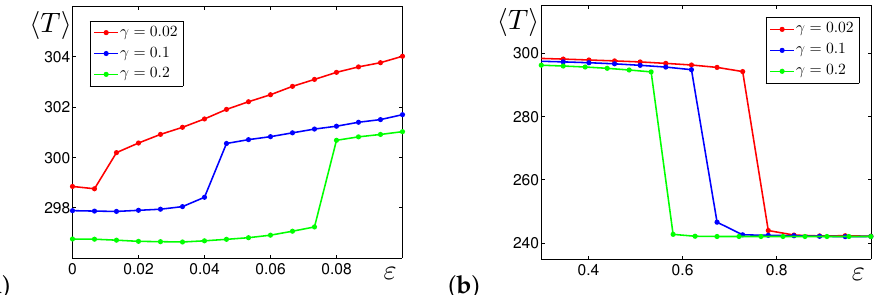
Figure 6. Direct numerical simulation: mean values of T -coordinates of system (2), (3) solutions versus ε for ( a ) σ 1 = 0, σ 2 = 1, ( b ) σ 1 = 1, σ 2 =